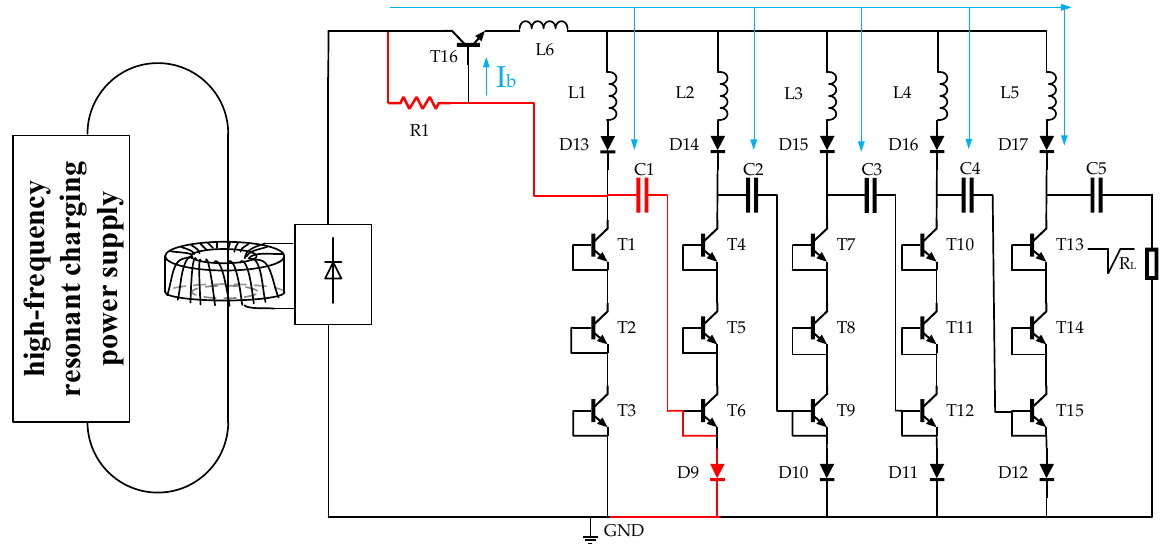
Figure 5. The nanosecond pulse generator using isolating inductors (circuit II).